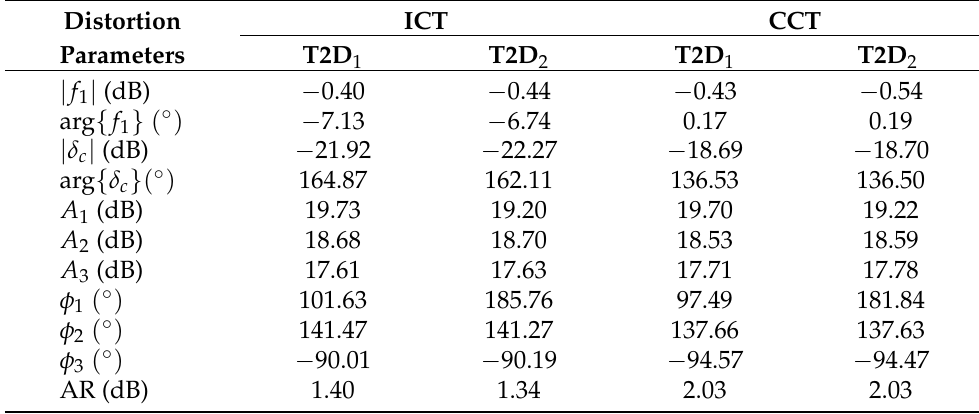
Table 3. Estimated distortion parameters of L-band HCP data using ICT and CCT